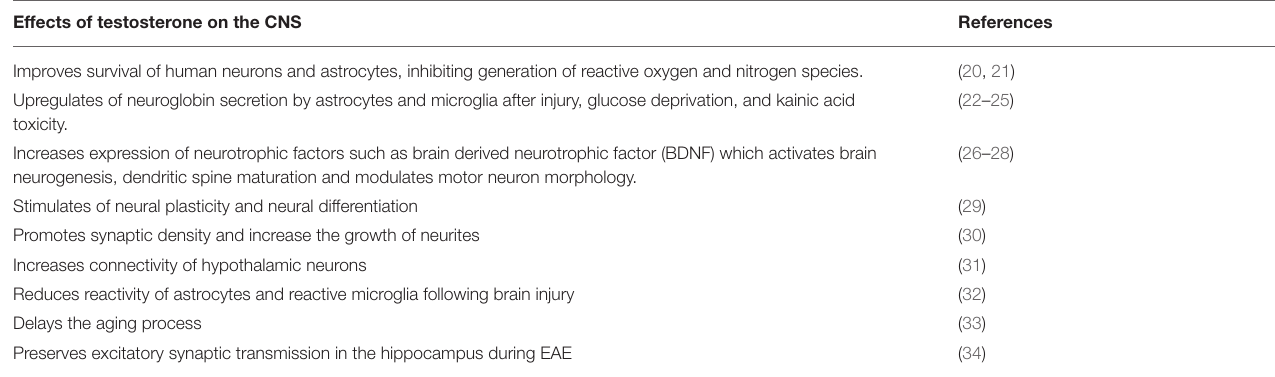
TABLE 1 | Main neuroprotective effects of